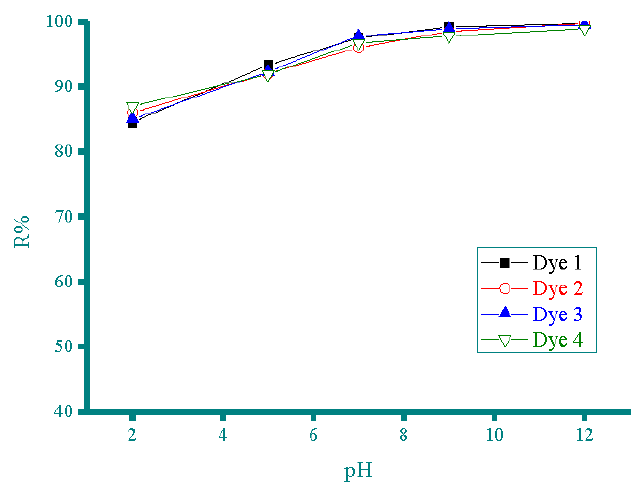
Figure 9. Effect of pH on the adsorption of dyes by 0.1 g of Fe 3 O 4 -carbon-based composite.